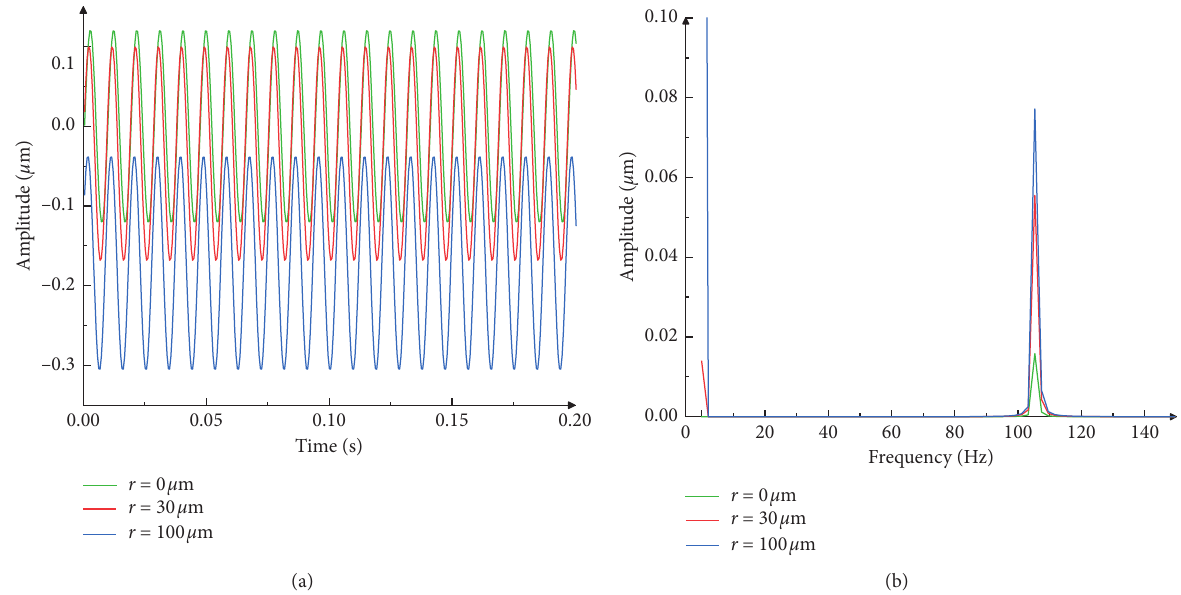
Figure 6: Time-domain and frequency-domain waveforms with mass eccentricity of 5 µ m at 6000r/min and different air gap eccentricity. (a) Time domain. (b) Frequency domain.